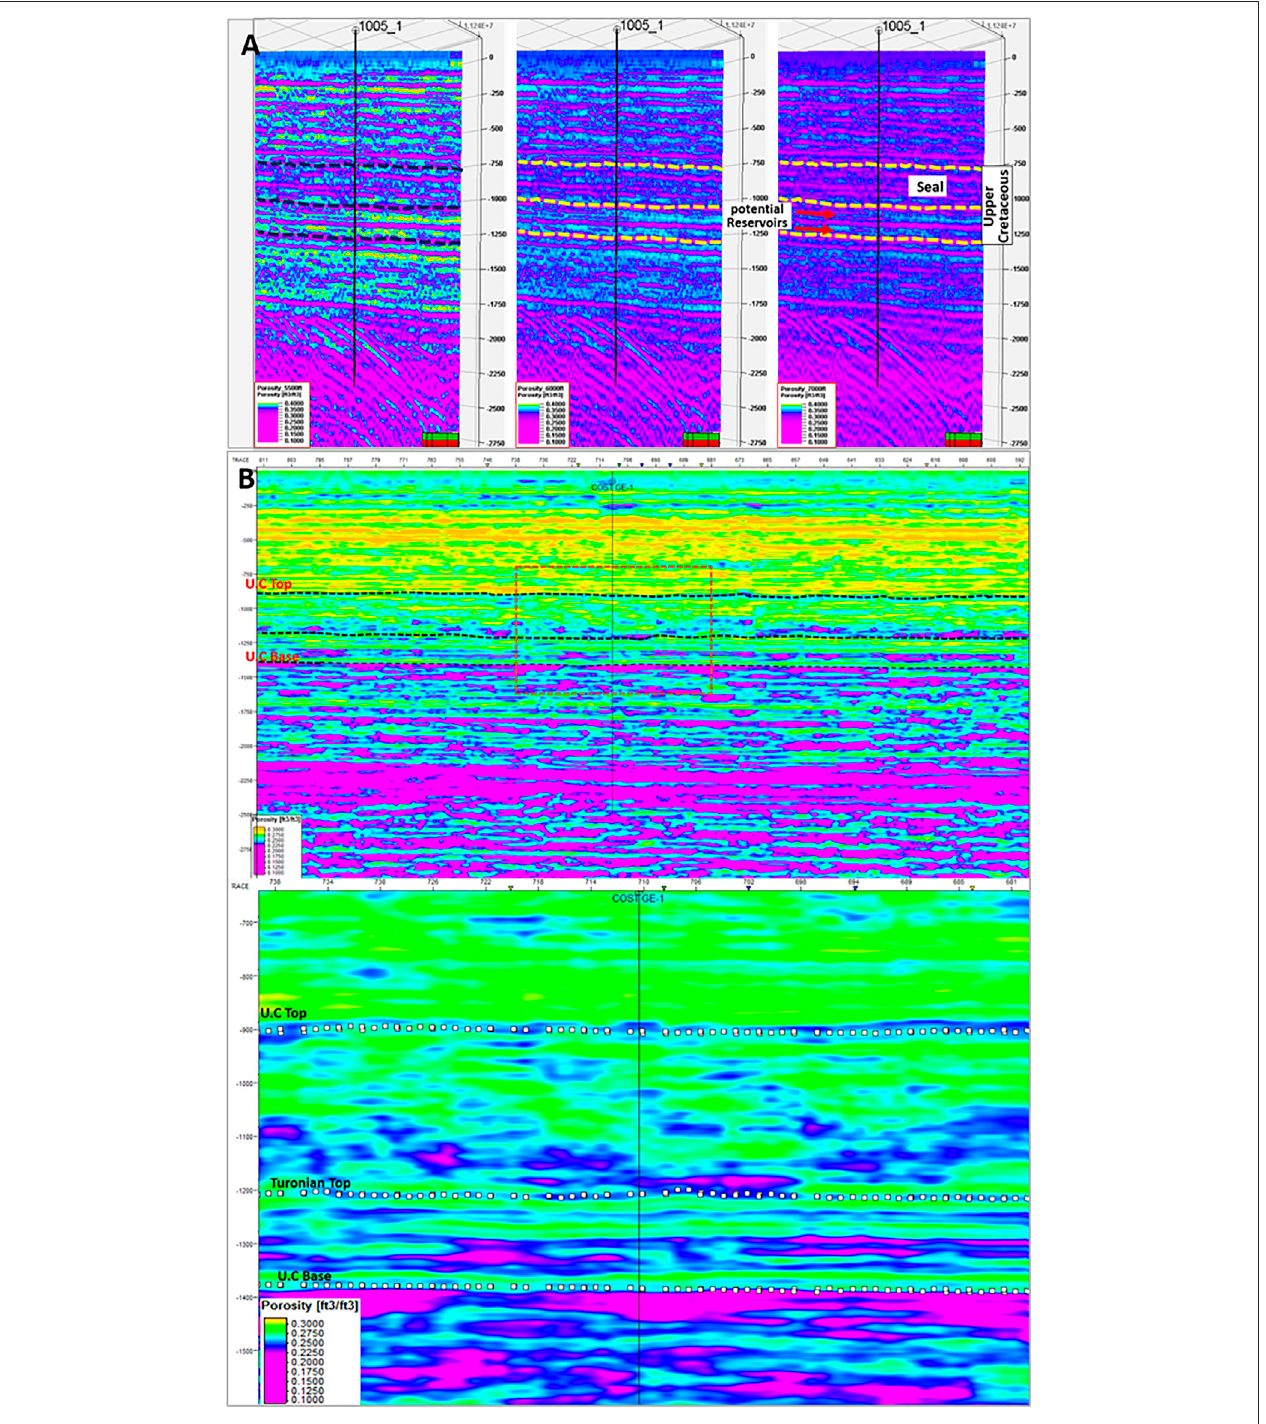
FIGURE 12 | (A) Extracted porosity from the acoustic impedance at three different intervals at the Transco 1005-1 well which discriminates two strata within the potential reservoir intervals at the Upper Cretaceous. (B) Extracted porosity from the acoustic impedance at the GE-1 well using the linear regression relationship of [Porosity=( − 0.0018164*AI) + 73.137], where the correlation coef fi cient is 0.75.